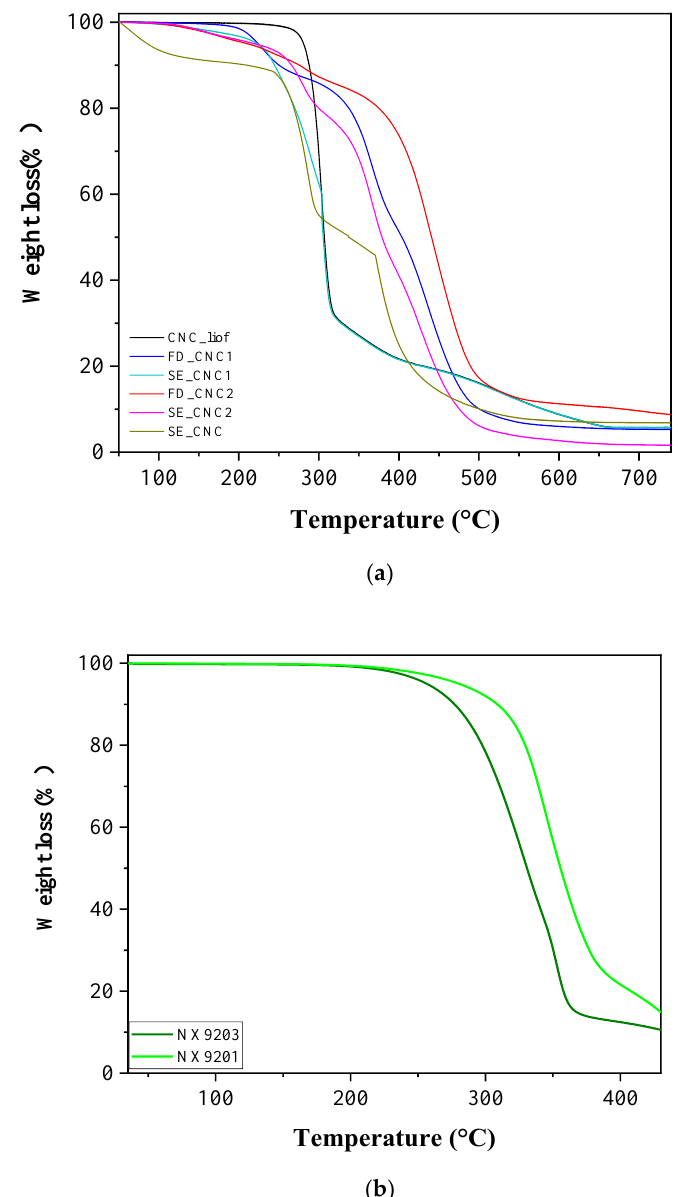
Figure 3. Thermogravimetric analysis (TGA) of the ( a ) CNCs fillers and ( b ) bio-polyols used for the